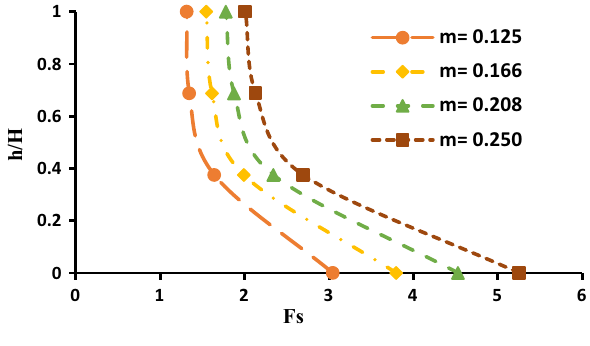
Fig. 13 Changes in factor of safety ( F loss ( h / H ) for the state ( � = 14